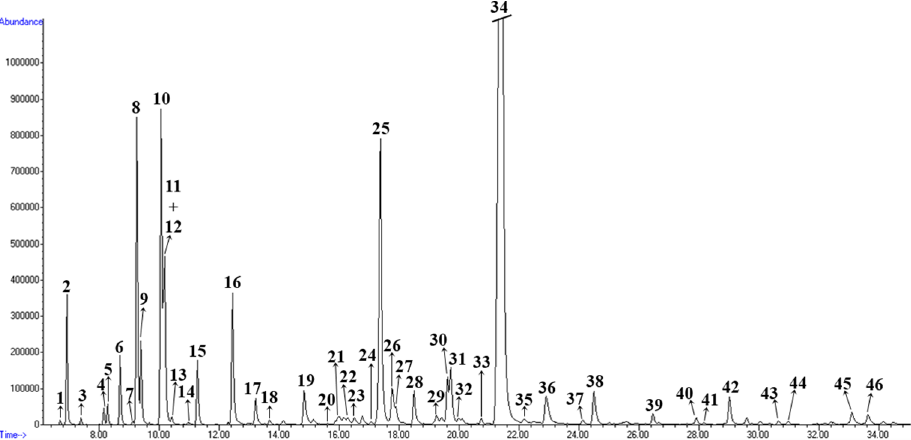
Figure 4. GC/FID chromatogram of essential oil isolated from wild fennel leaves.